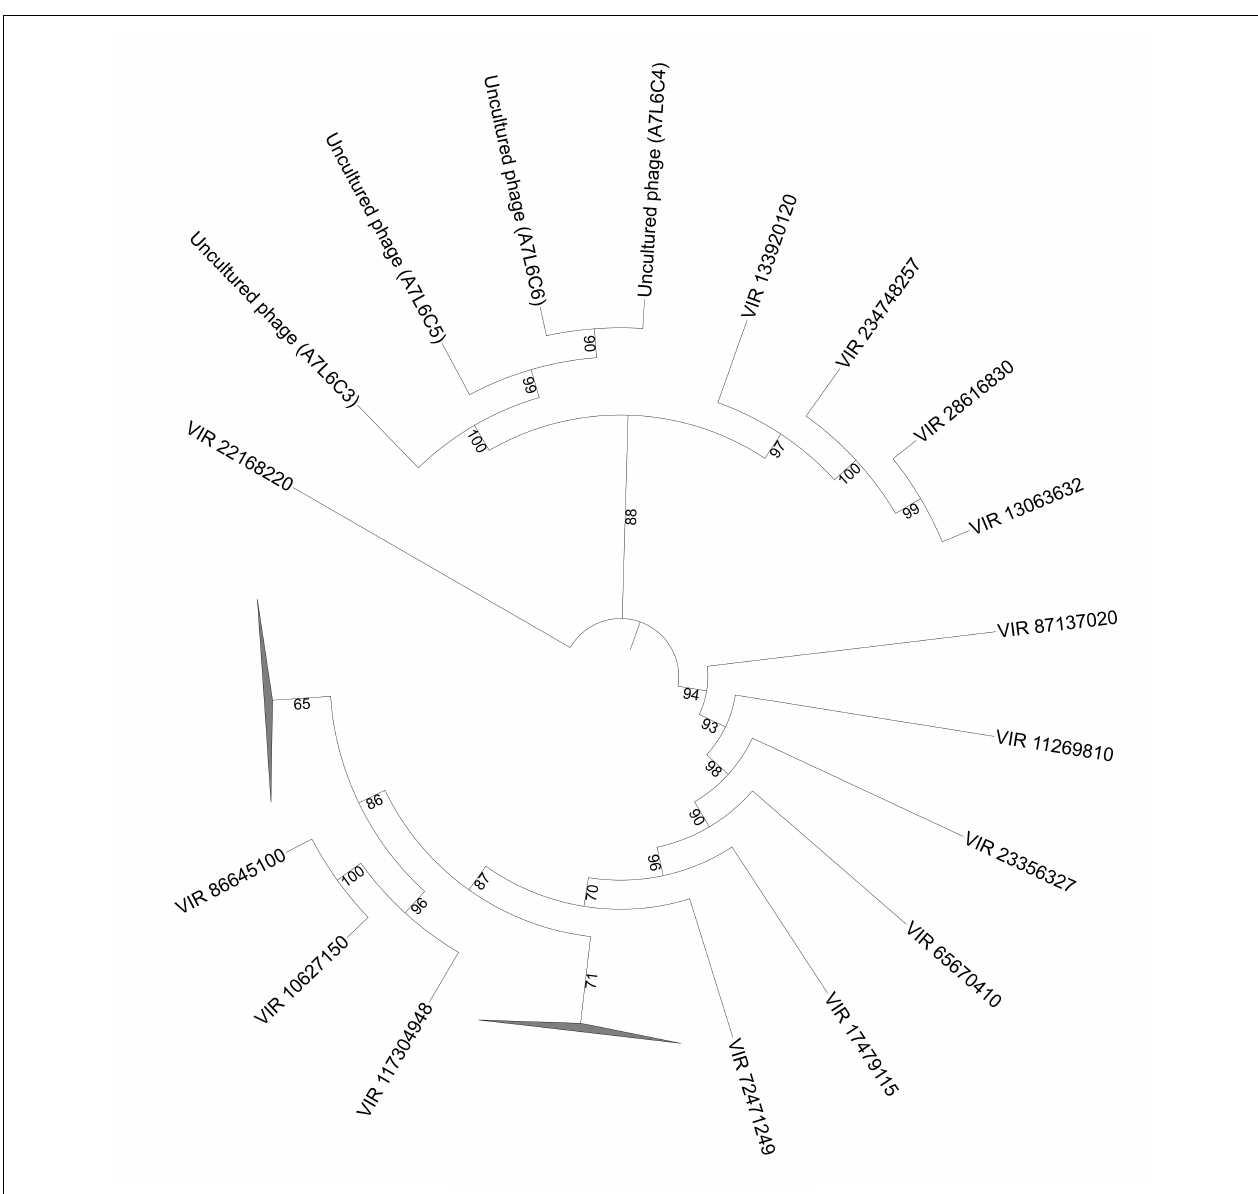
FIGURE 5 | Phylogenetic analysis of viral fractions from Shark Bay stromatolites for the major capsid protein (VP1) in Microviridae viruses. Maximum likelihood phylogenetic tree of VP1 protein sequences obtained from Microviridae viruses in Shark Bay stromatolites. Reference sequences were retrieved from the Uniprot database. Short sequences ( < 160 amino acid) were removed prior to alignment. Alignments were performed using MUSCLE and gaps in alignment were removed with UGENE. The tree was constructed with IQ-TREE v. 1.6.1 with 1000 bootstrap replicates and was visualized with iTOL. Number indicates bootstrap values, nodes with bootstrap values lower than 70 were not shown and represented by the collapsed branch. The collapsed branches in this figure represent reference sequences from Desnues et al. (2008) for major capsid protein (VP1) that have lower than 70 bootstrap values.